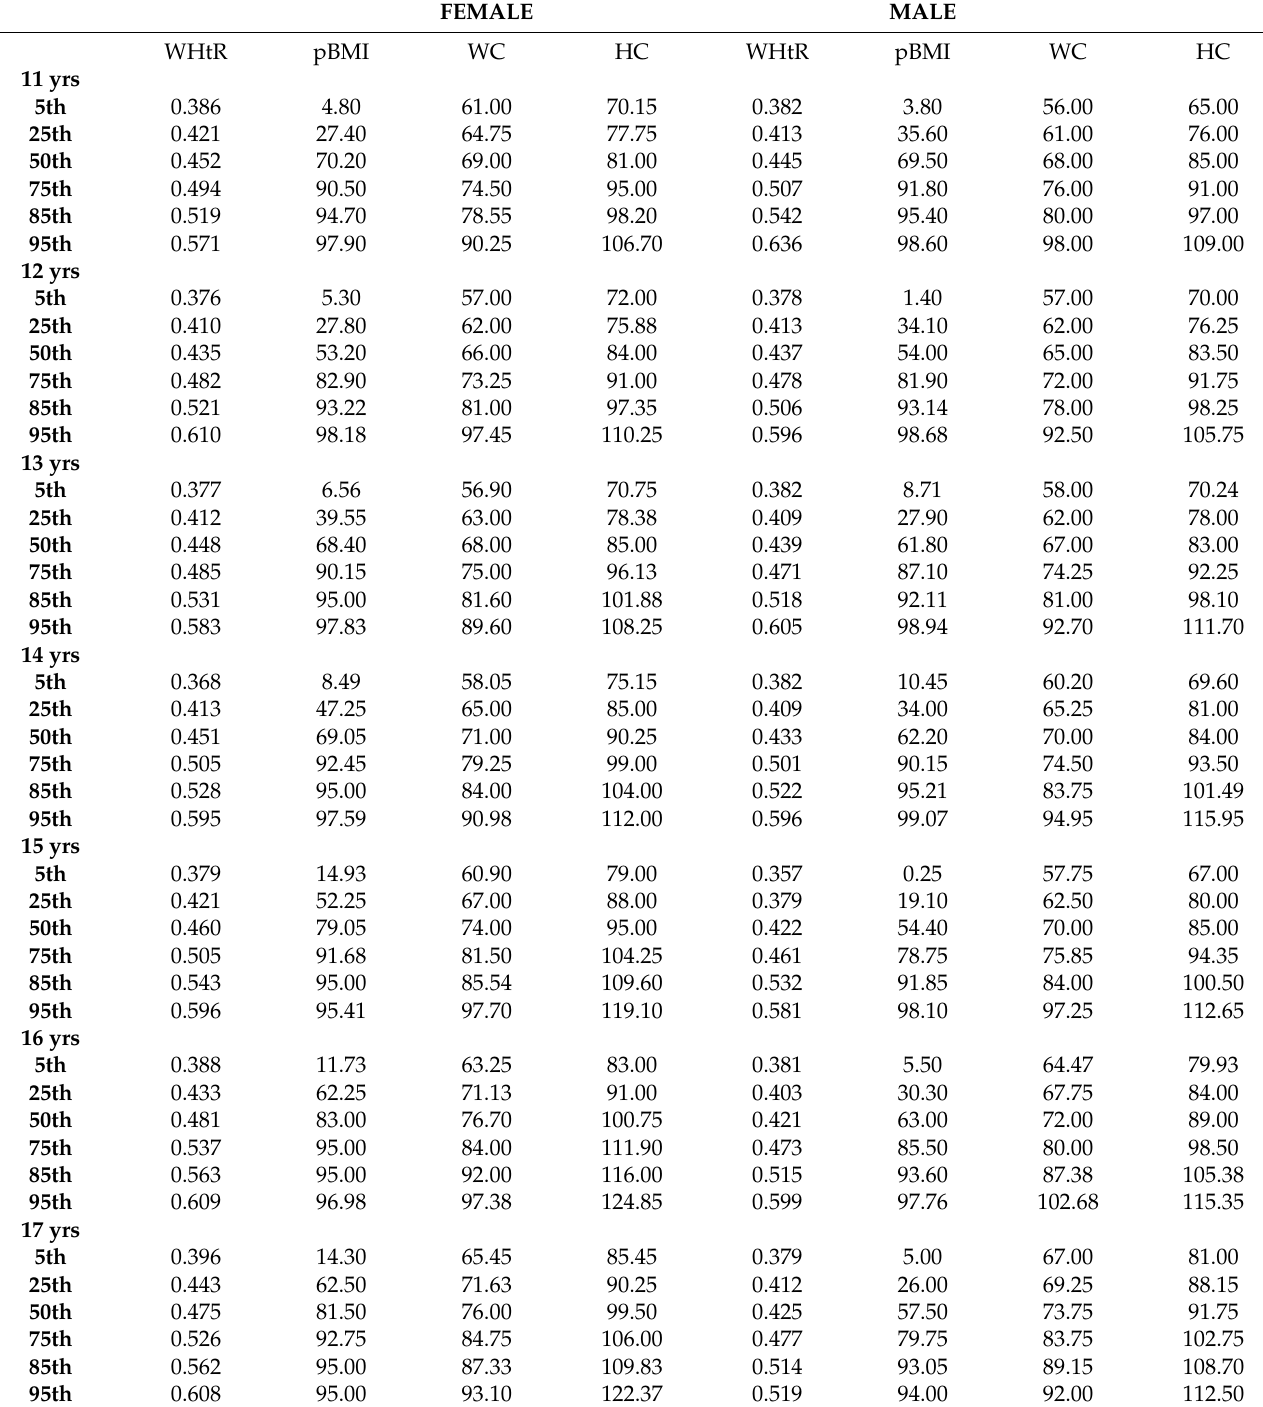
Table 8. Percentiles of the various obesity measures in